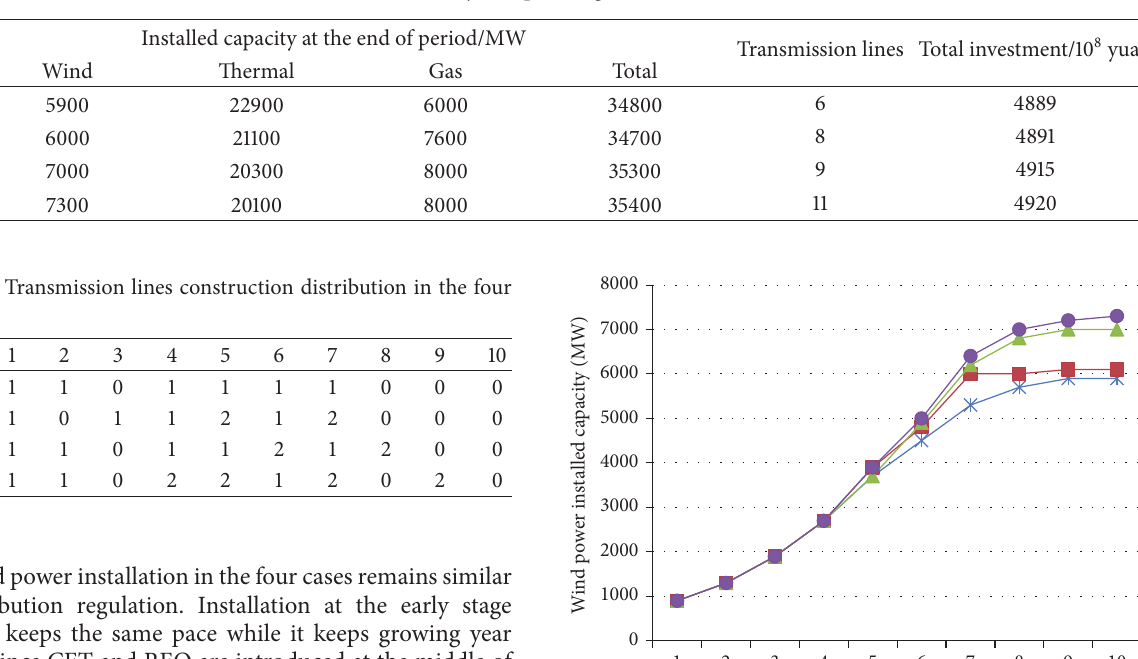
Table 16: Power system planning results in 4 cases.